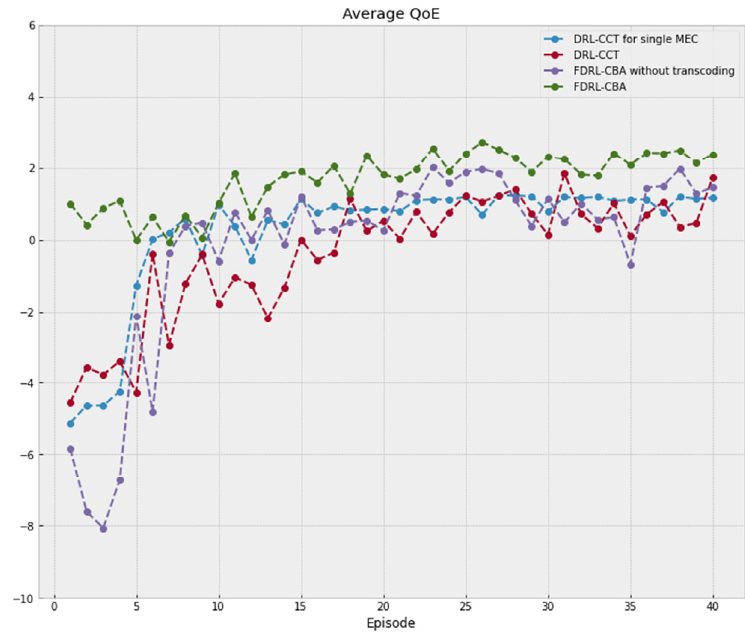
Figure 7. The QoE performance in different algorithms.